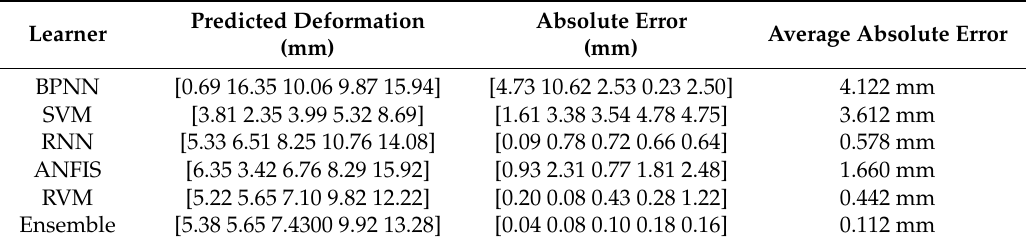
Figure 9. Prediction results among the BPNN, SVM, RNN, ANFIS, RVM, and ensemble algorithms. Table 5. Prediction results.